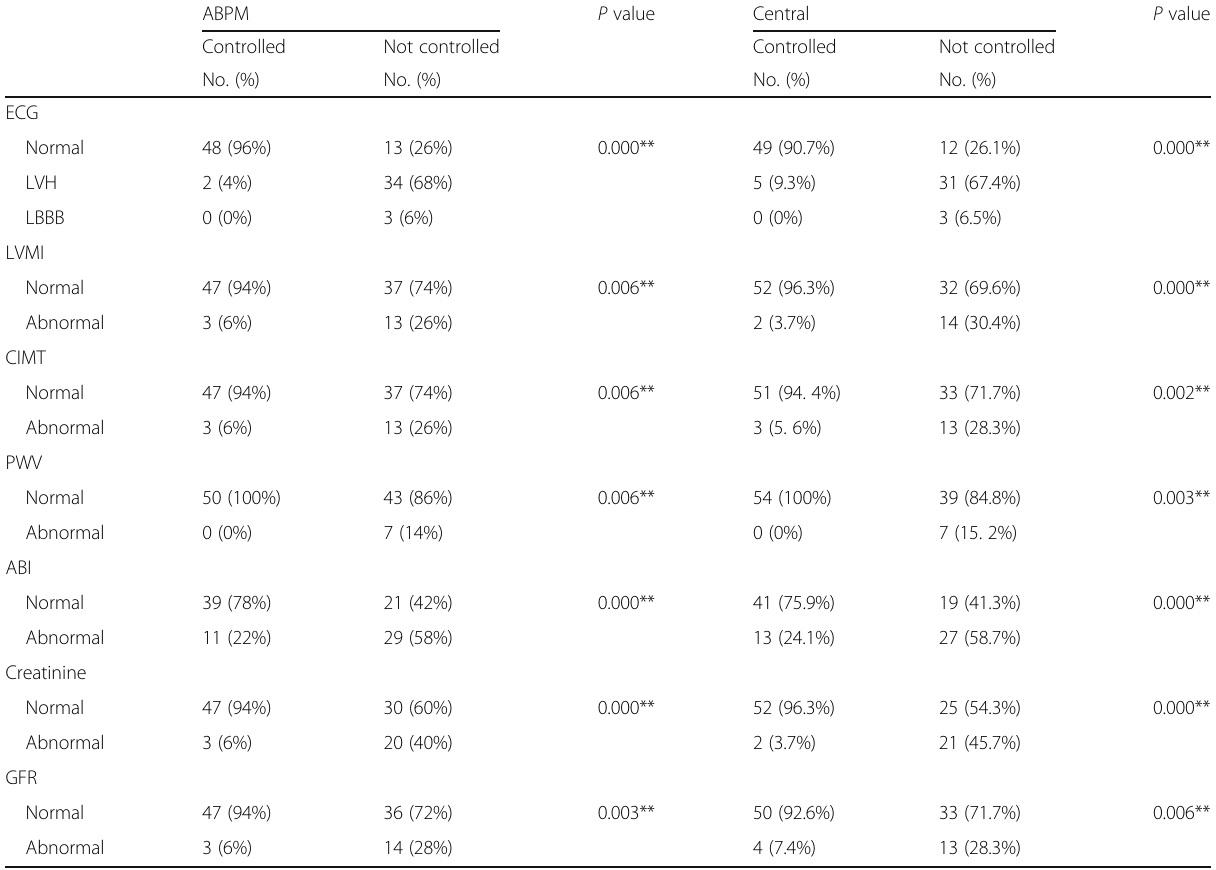
Table 3 Relation between SBP measured by different tools monitoring and early hypertensive end organ